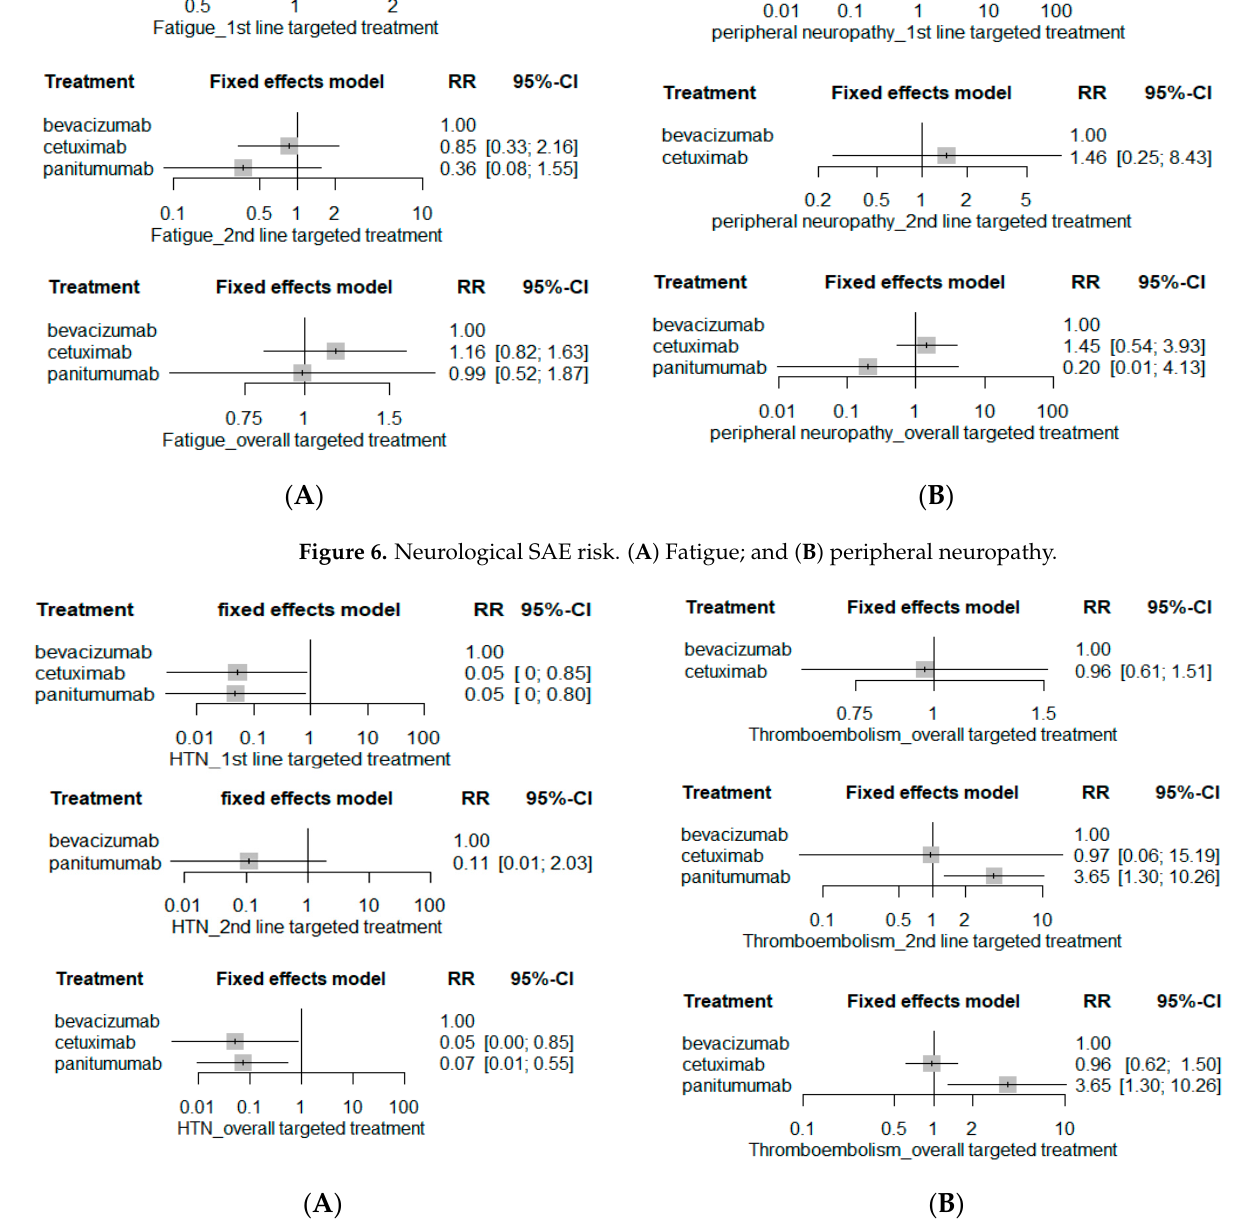
Figure 7. Cardiovascular SAE risks. ( A ) Hypertension; and ( B ) thromboembolism.